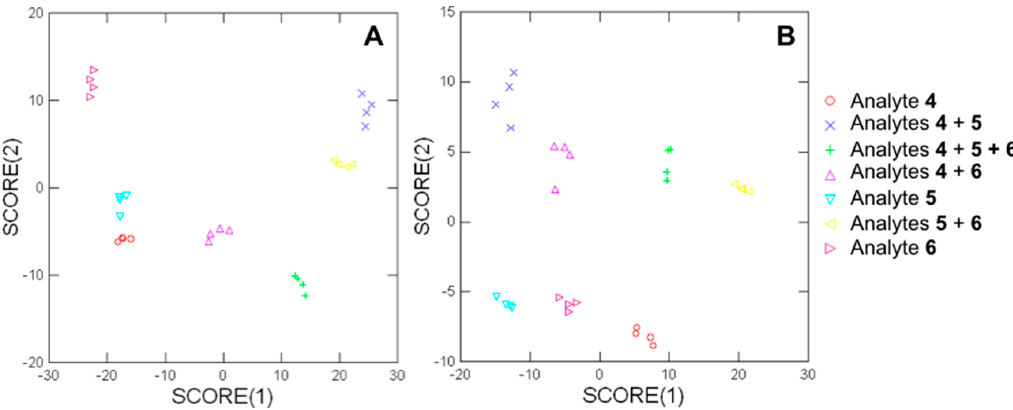
Figure 11. Linear discriminant analysis of mixtures of analytes 4 – 6 with fluorophore 9 in ( A ) Kingston snow and ( B ) deionized water, with cyclodextrins as predictors.